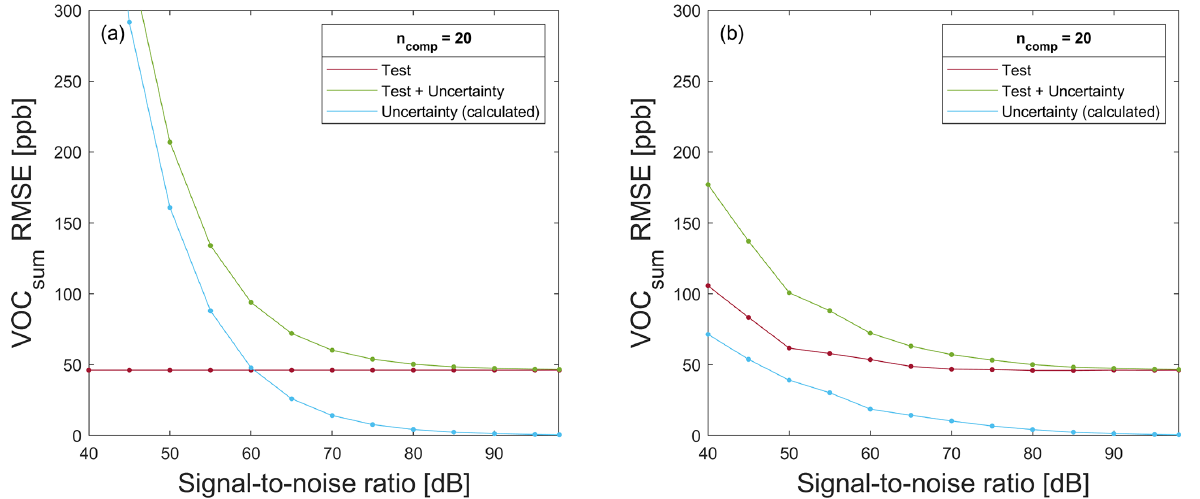
Figure A5. RMSE for testing a model trained with 80% (a) raw data and (b) noisy data for VOC sum prediction on 20% test data without (red) and with associated uncertainty values (green), in addition to the calculated uncertainty RMSE (blue) resulting from the difference in T + U − RMSE and T − RMSE.